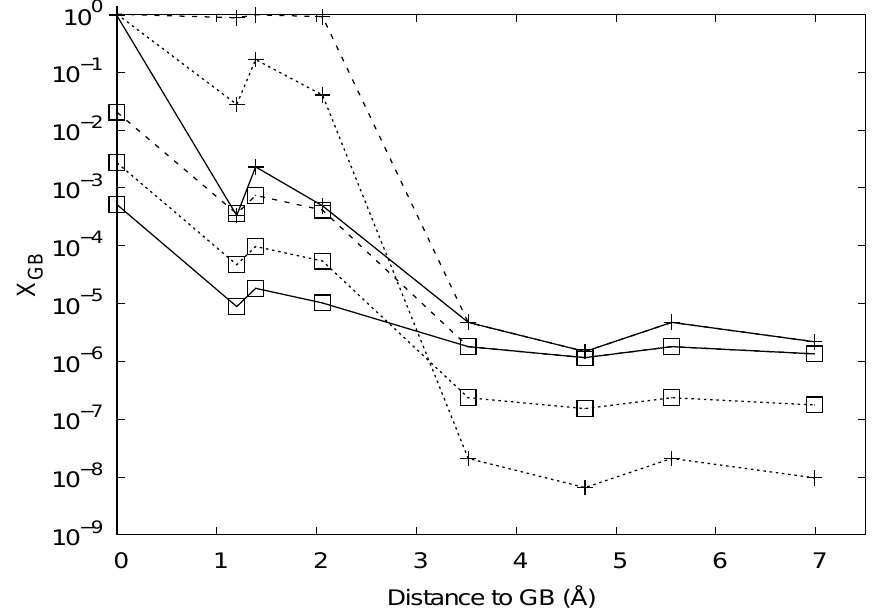
Figure 9. Segregation profiles for the sites in the vicinity of the grain boundary. The curves with cross symbols correspond to a temperature of 300 K, the curves with box symbols correspond to a temperature of 800 K. For both temperatures, the solid lines correspond to the segregation from a bcc bulk site with formation enthalpy ∆ E = 0.25 eV to the sites with energies and spatial distance to the grain boundary plane as reported in [15]. The dashed curves assume that the segregating hydrogen atom moves into a hydrogen enriched region which is limited to those sites within 2 Angstroms distance to the grain boundary plane. The hydrogen enriched zone has a reduced bulk modulus, and the resulting shift is about 255 meV. The dotted lines correspond to data that takes account that high local plasticity densities act as effective traps and that the hydrogen has to overcome the binding energy of about 140 meV. We note that the hydrogen is absorbed into the dislocations both for 300 K and 800 K from those sites that are more than 2 Angstroms away, expressed by positive segregation energies. This leads to a weak depopulation of this region at 800 K and a pronounced depopulation at 300